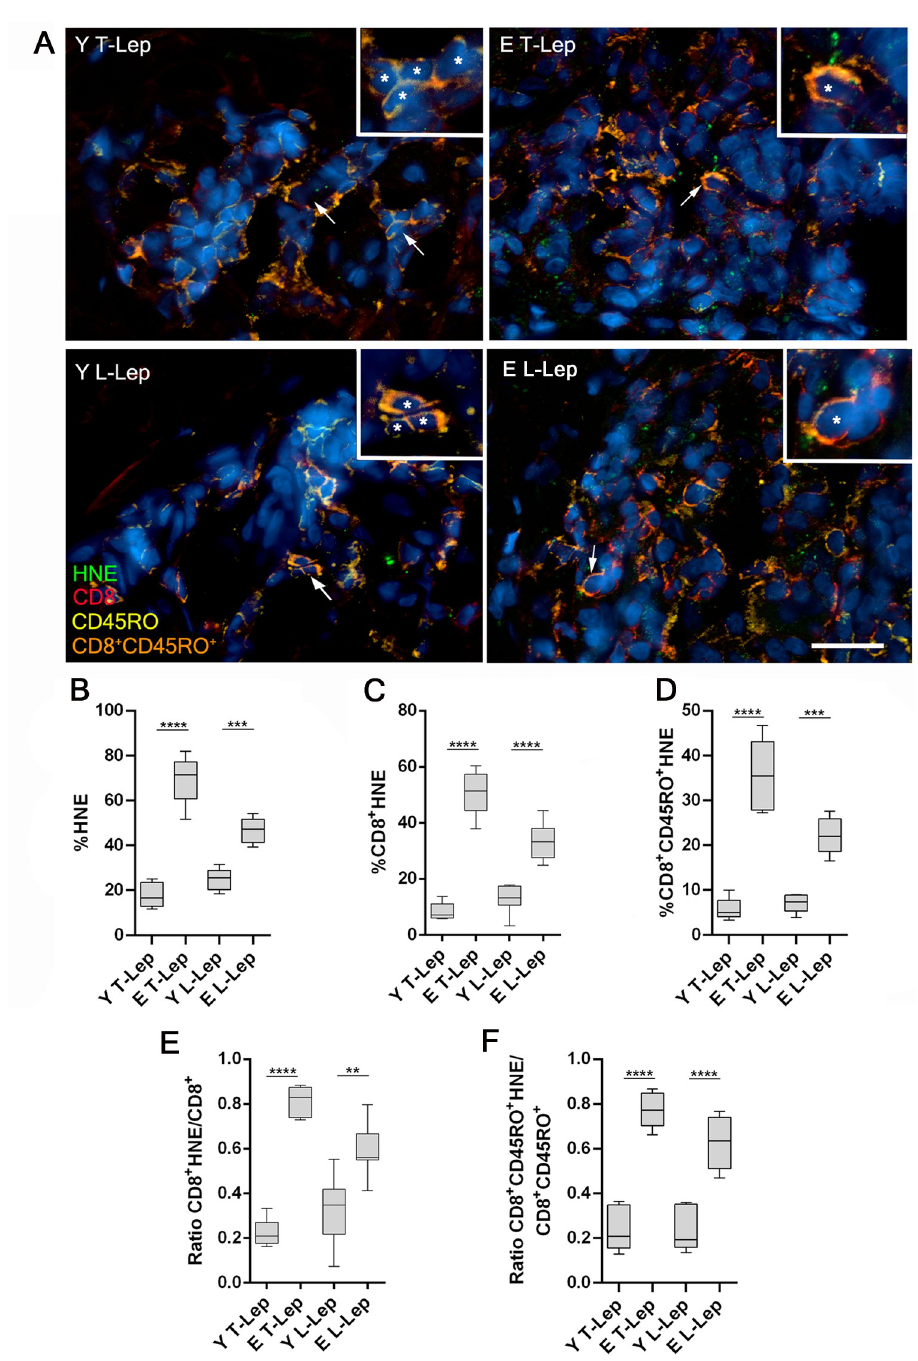
Fig 3. Analysis of oxidative stress by quantifying 4-hydroxynonenal in skin lesions of leprosy patients. Immunofluorescence assays were performed to determine the number of memory CD8 + T cells (CD8 + CD45RO + ) associated with 4-hydroxynonenal (HNE) signal, as well as HNE abundance in tissue. ( A ) Representative images of skin lesions from a young paucibacillary patient (Y T-Lep), an elderly paucibacillary patient (E T-Lep), a young multibacillary patient (Y L-Lep) and an elderly multibacillary patient (E L-Lep), presenting HNE (green, Alexa Fluor 488), CD8 (red, Alexa Fluor 594), CD45RO (yellow, Alexa Fluor 633) and nuclei stained by DAPI (blue). Arrows and asterisks indicate CD8 + CD45RO + cells, stained in orange. In the enlarged inserts, more intense HNE signal in elderly T-Lep and L-Lep patients is observed. Scale bar represents 40 μ m in main image and 20 μ m in inserts. The graphs present frequency of ( B ) HNE-associated cells, ( C ) double-positive CD8 + HNE-associated cells, ( D )